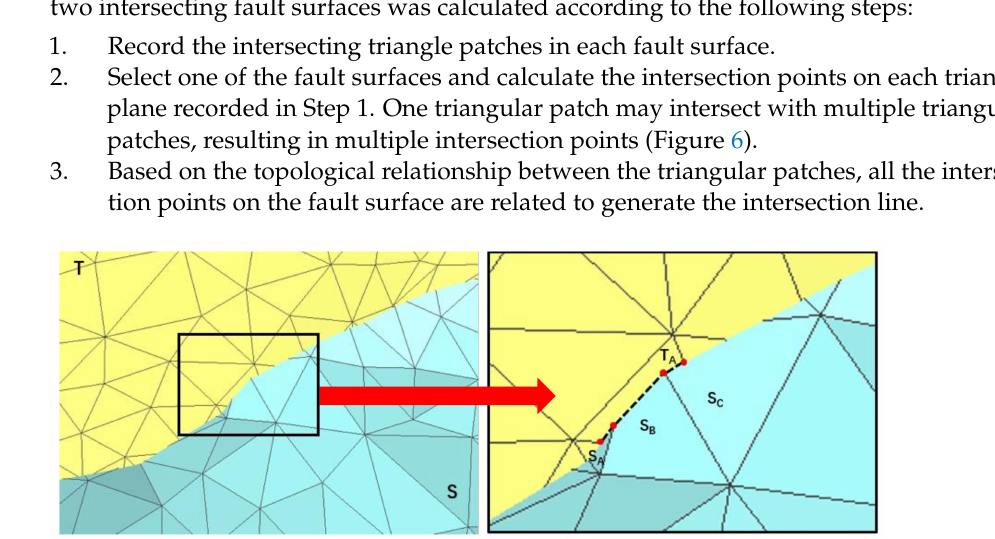
Figure 6. Schematic diagram of the intersection of triangles (The triangular patch T A in the fault surface T intersects with the triangular patches S A , S B , and S C of the fault surface S at the same time, resulting in four intersection points and the intersecting